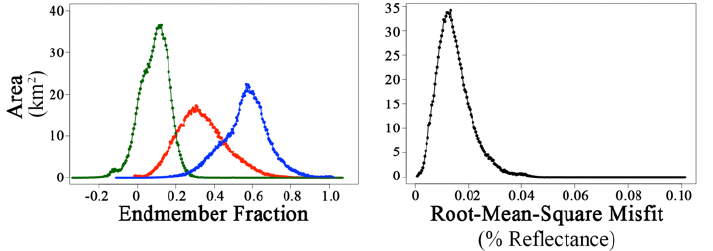
Figure 4. Mixture model fraction histograms. ( Left ) S, V, and D fractions are shown in red, green, and blue, respectively. S and D fractions are almost entirely (>99% pixels) within physical bounds. Twelve percent of pixels show negative V fractions, due to variation in NIR spectral convexity driven by substrate diversity which is not well accommodated by a single S endmember. ( Right ) Root-mean-square (RMS) misfit histogram of the generalized model is shown in black. Despite the geologic complexity of the study area, RMS misfit is <5% for >98% of pixel spectra. However, rather than focusing on the aggregate mixture model misfit, its pixelwise spectral signature—a small fraction of the total variance—drives the remaining analysis.